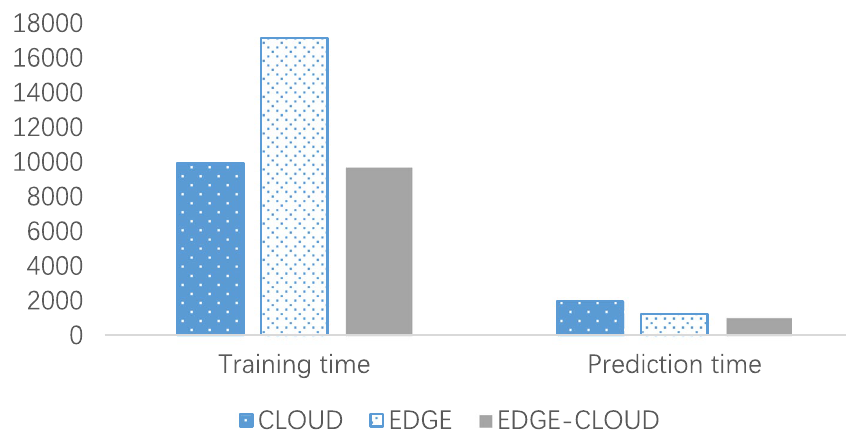
Fig. 11 Model training and prediction times using edge, cloud, and edge-cloud